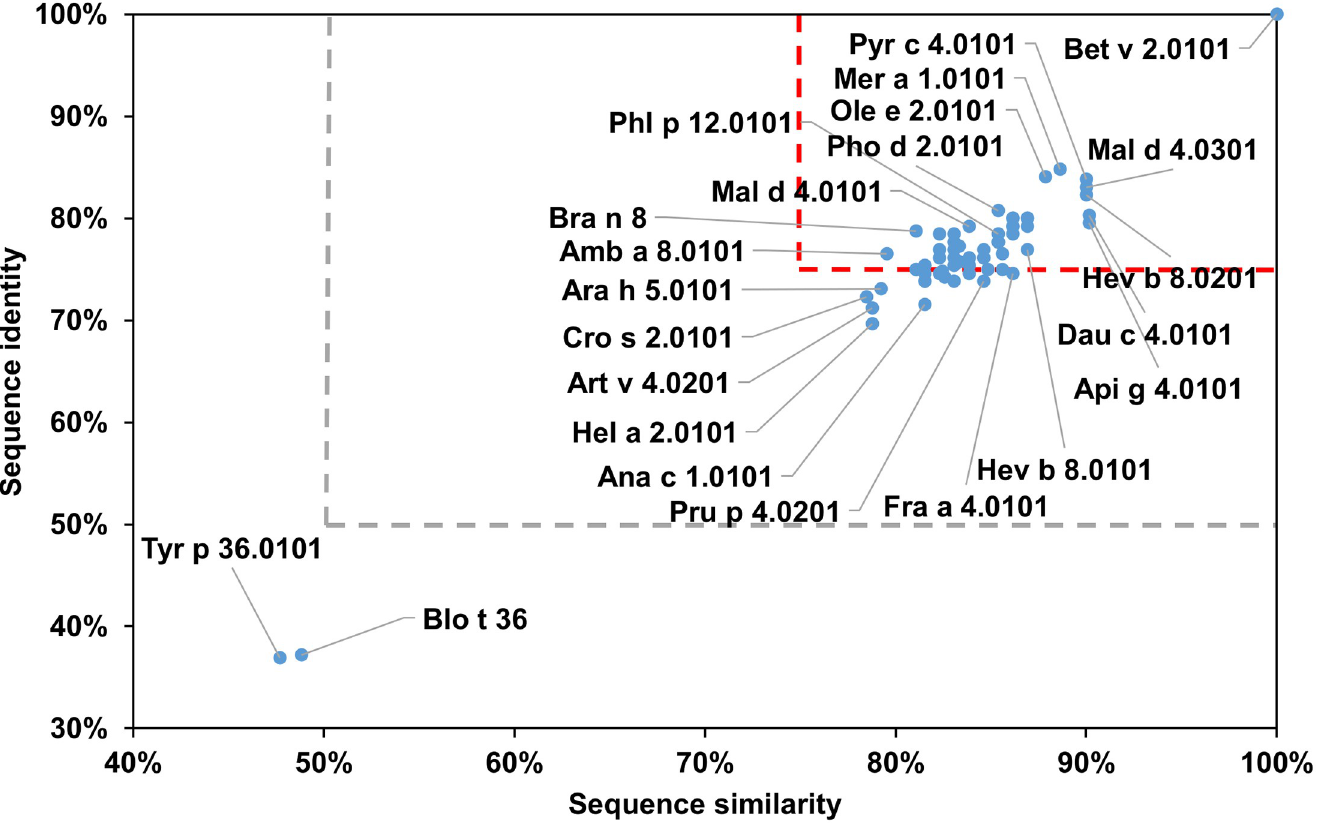
Fig 20. Plots showing a relative homology of allergens from profilin family. Comparison of family members to Bet v 2.0101. Only selected members of the family are labeled. Red and gray dashed lines indicate respectively 75% and 50% sequence identity and similarity, or 0.75, and 0.50 A-RISC